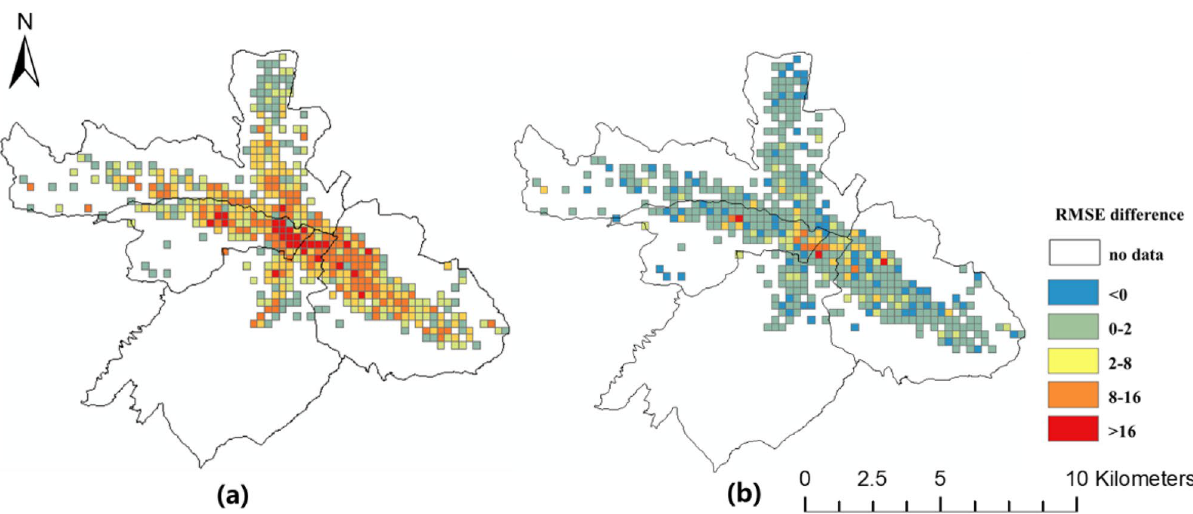
Figure 10. Spatial distributions of the RMSE differences among different models: ( a ) FPM-geo and SVR; ( b ) FPM-geo and